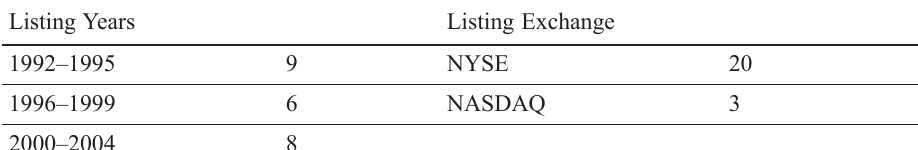
Table 4. Descriptive statistics for listed fi rms on